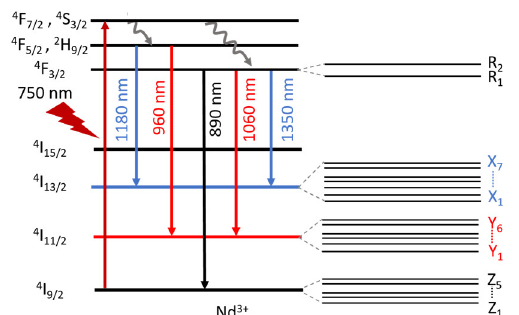
Figure 4. Nd 3+ ion energy level diagram: The absorption transition 4 I 9/2 → 4 F 7/2 , 4 S 3/2 (excitation at 750 nm) is followed by non-radiative decay to 4 F 5/2 , 2 H 9/2 and 4 F 3/2 states, respectively. With depopulation of these states’ emission bands centered around 960 nm ( 4 F 5/2 , 2 H 9/2 → 4 I 11/2 ) and 1180 nm ( 4 F 5/2 , 2 H 9/2 → 4 I 13/2 ) as well as around 890 nm, 1060 nm, 1350 nm occur. Latter ones correspond to the 4 F 3/2 → 4 I 9/2 , 4 F 3/2 → 4 I 11/2 , and 4 F 3/2 → 4 I 13/2 transitions, respectively. Due to the ligand field splitting, the 4 F 3/2 , 4 I 9/2 , 4 I 11/2 , and 4 I 13/2 states are split into two (R 1 , R 2 ), five (Z 1 –Z 5 ), six (Y 1 –Y 6 ) and seven (X 1 –X 7 ) Stark sublevels, respectively. Figure 5 illustrates the temperature-dependent emission spectra of complex [Nd( L2 ) 3 (NO 3 ) 3 ] ( 3 ). At low temperature (5 K), ten emission lines of the 4 F 3/2 → 4 I 9/2 transition can be observed, which overlap strongly at higher temperatures due to the broadening of electron-phonon interactions. Despite low-temperature measurements, 4 F 3/2 4 F → 4 I → 4 I 11/2 and 3/2 13/2 transitions are less resolved. This is due to the spectral overlap between the emission lines since they lie close together.